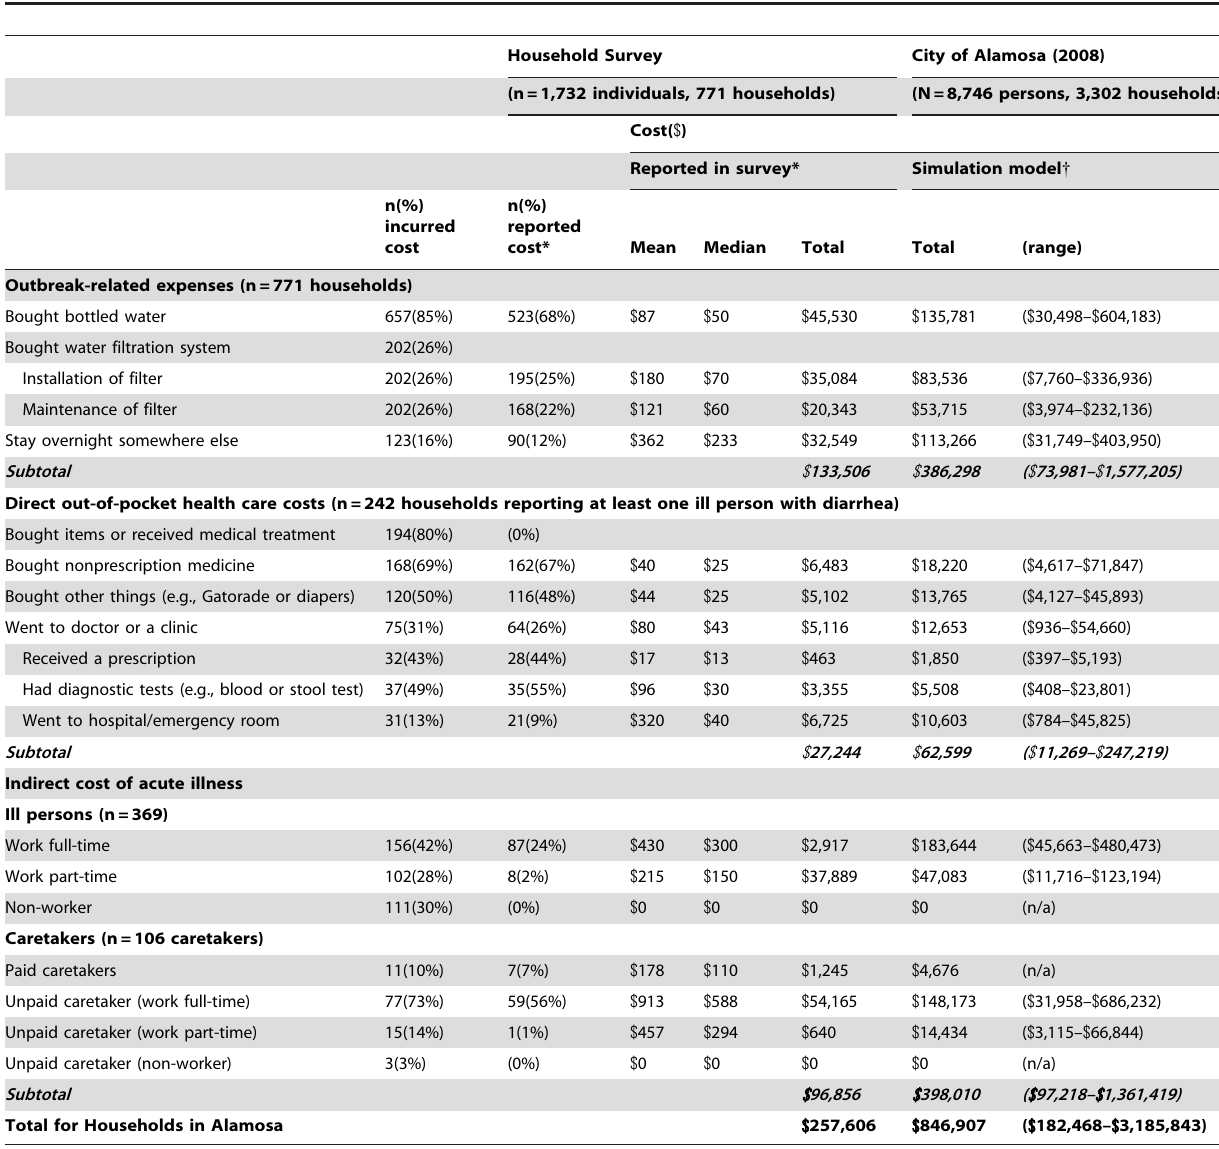
Table 1. Costs to City of Alamosa households associated with an outbreak of salmonellosis, Alamosa, Colorado 2008.